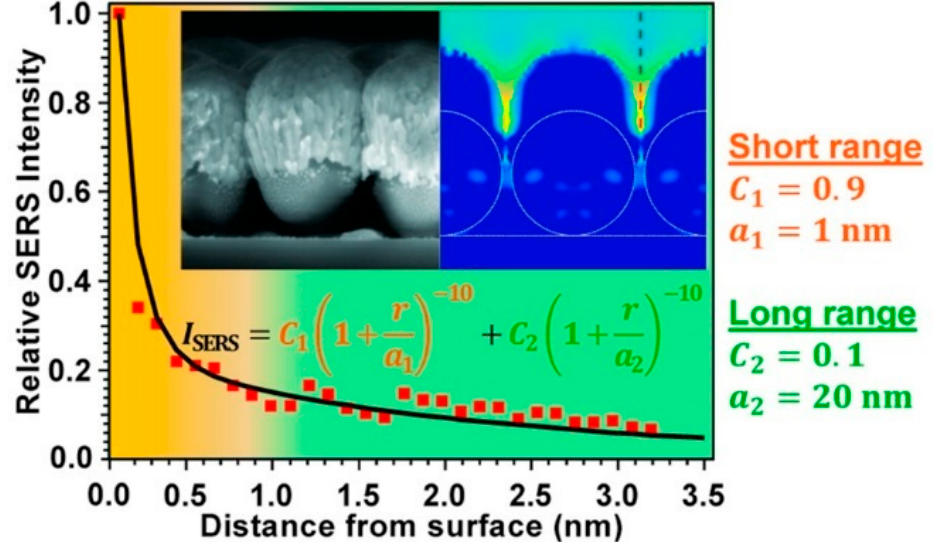
Figure 14. The metallic substrate is represented by the hemispheroid; on top of it, the arachidic acid layer (spacer) and the phthalocyanine (Raman probe). Reproduced with permission from Kovacs et al. [235]. Copyright (1986), American Chemical Society.